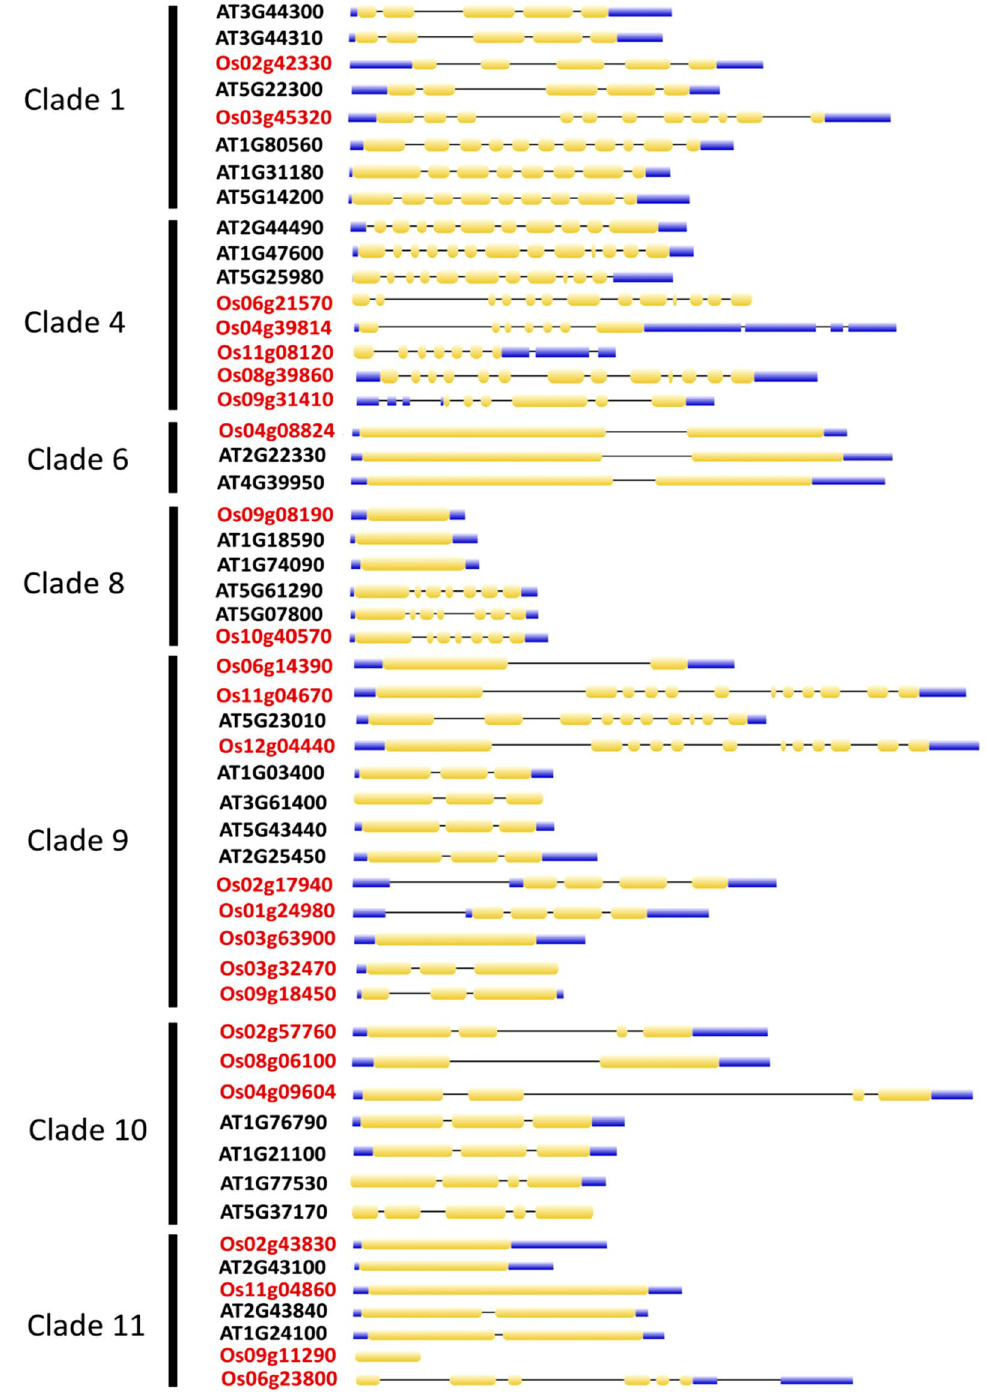
Figure 4. Illustration of the Arabidopsis thaliana and Oryza sativa sulfur-encoding biosynthetic gene structure. Genes are grouped according to clades. The A. thaliana (ATXXXXXXX) and O. sativa (OsXXXXXXXX) gene IDs are written in black and red, respectively. Exons are indicated as yellow round-corner rectangles and introns with solid black